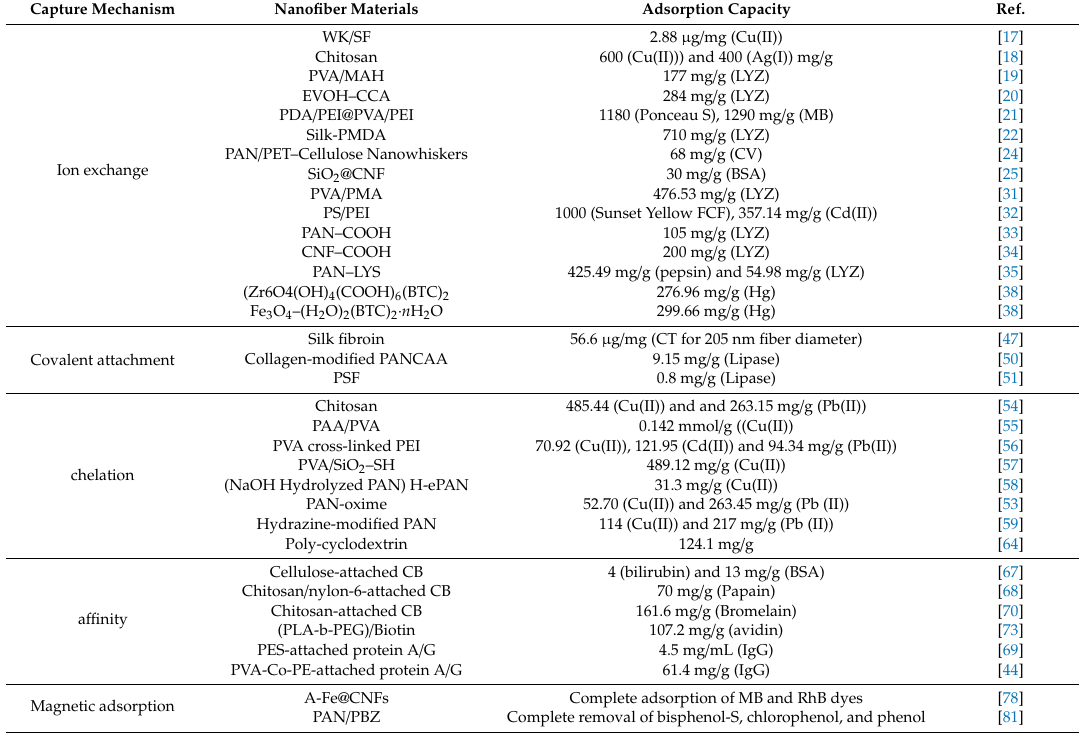
Table 1. Summary of electrospun nanofibrous membranes for chemical